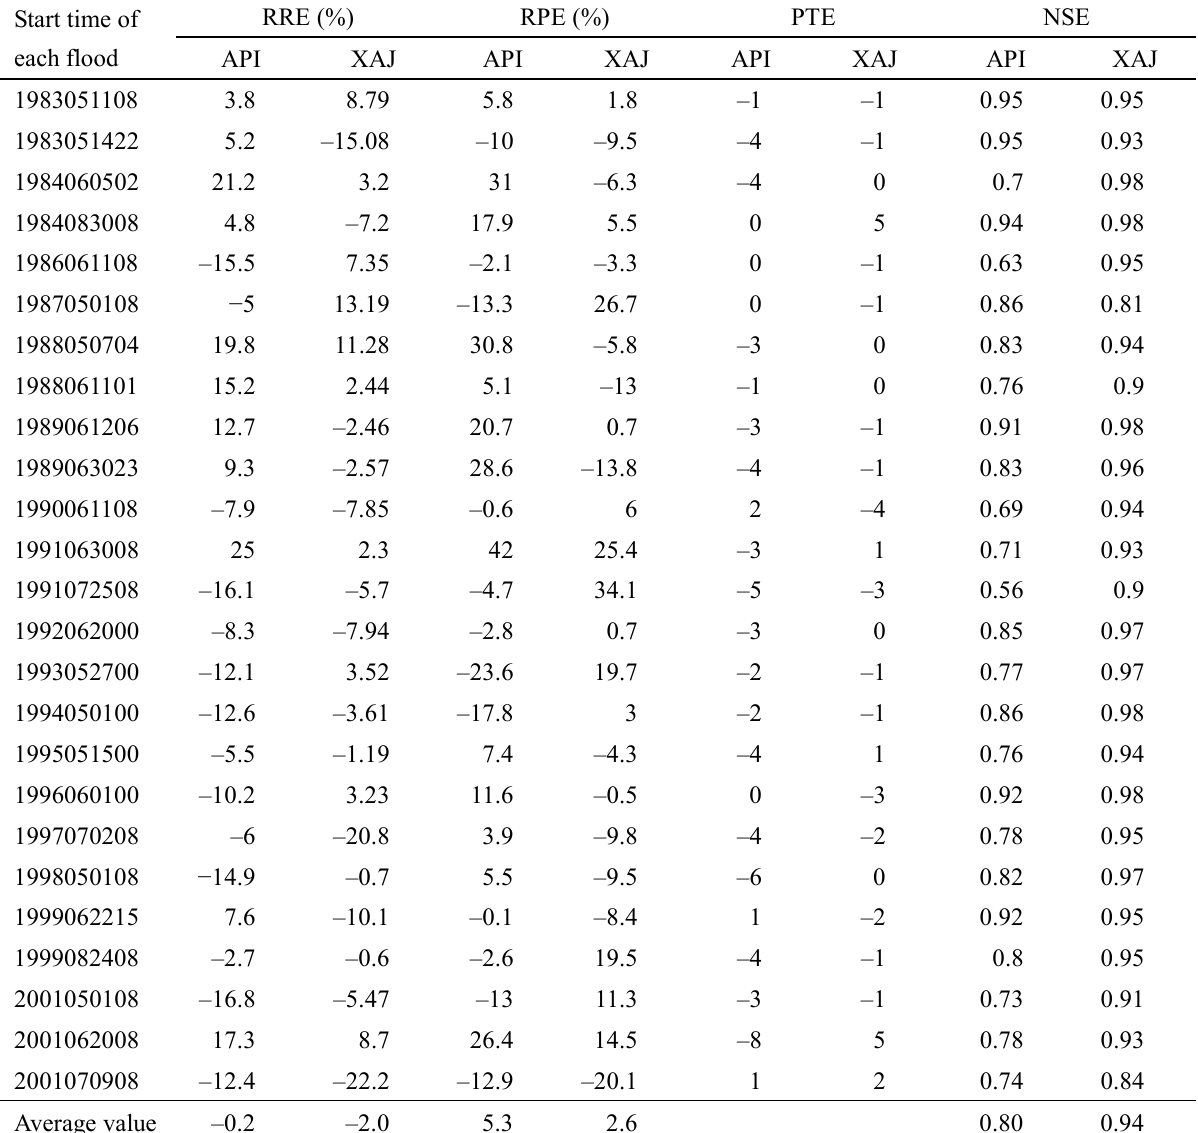
Table 2 Flood simulation characteristic value of API and XAJ model on Tunxi basin. Start time of each